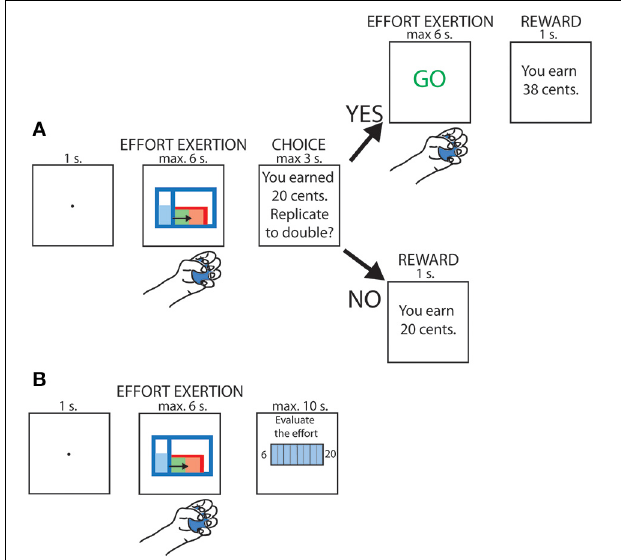
FIGURE 1 | schematic depiction of the task. (A) Trials in which replication of the effort was proposed. (B) Trials in which subjective rating of the effort was